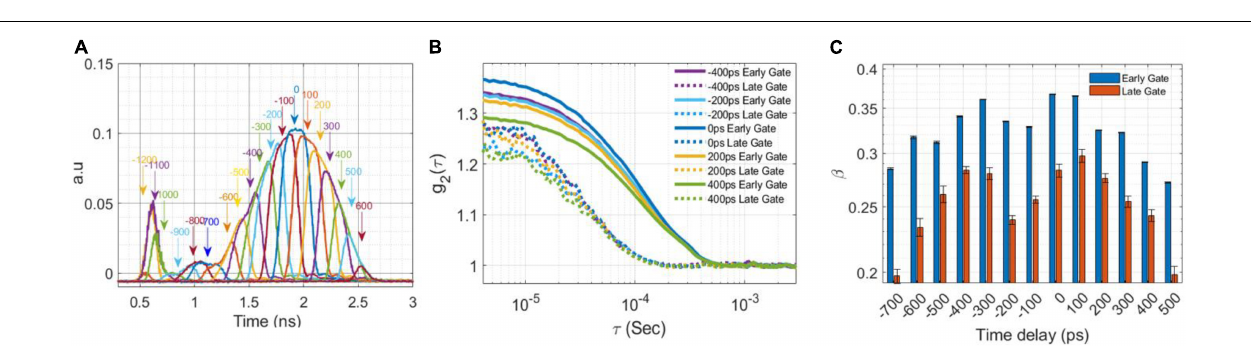
FIGURE 2 | Laser shaping. (A) The laser pulses (FWHM of 300 ps at 25 MHz) derived from delaying the RF signal to the EOM with respect to the seed laser by 100 ps increments (B) The autocorrelation curve, g 2 ( τ ) from an intralipid phantom for a subset of the pulse shaping delays in (A) at 1.5 cm SD separation calculated for the early and late gates at 200 ps gate width. (C) The measured coherence factor, β , as a function of the EOM temporal alignment calculated at early and late gates.